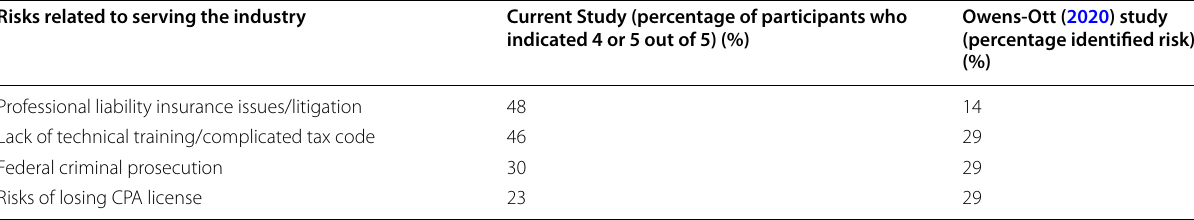
Table 8 Comparison of risks CPAs identified from this study and the 2020 Owens‑Ott study Risks related to serving the